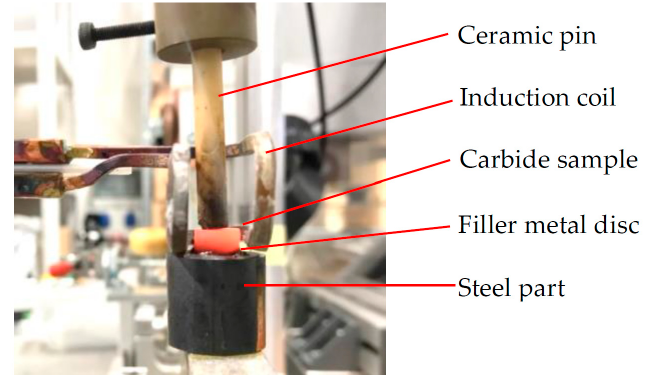
Figure 3. Induction brazing joint assembly.